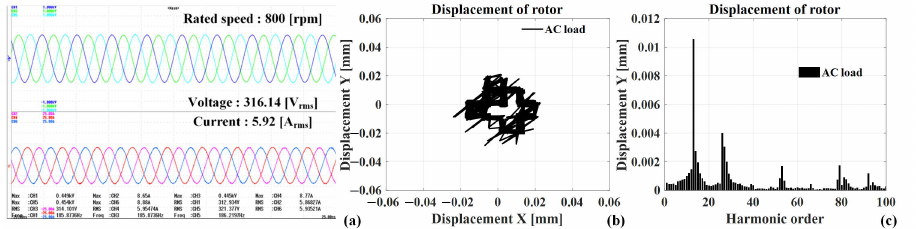
Figure 16. Experimental results for the AC load condition: ( a ) measurement of voltage and current; ( b ) rotor displacement; ( c ) FFT analysis results for the rotor